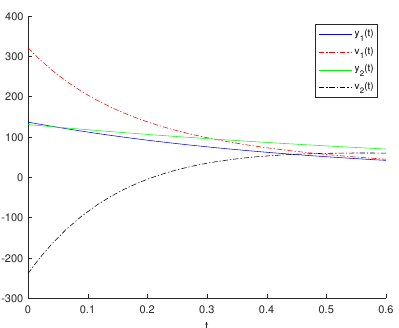
Figure 5. The curves of y 1 ( t ) , y 2 ( t ) , v 1 ( t ) , v 2 ( t ) from Example 2.